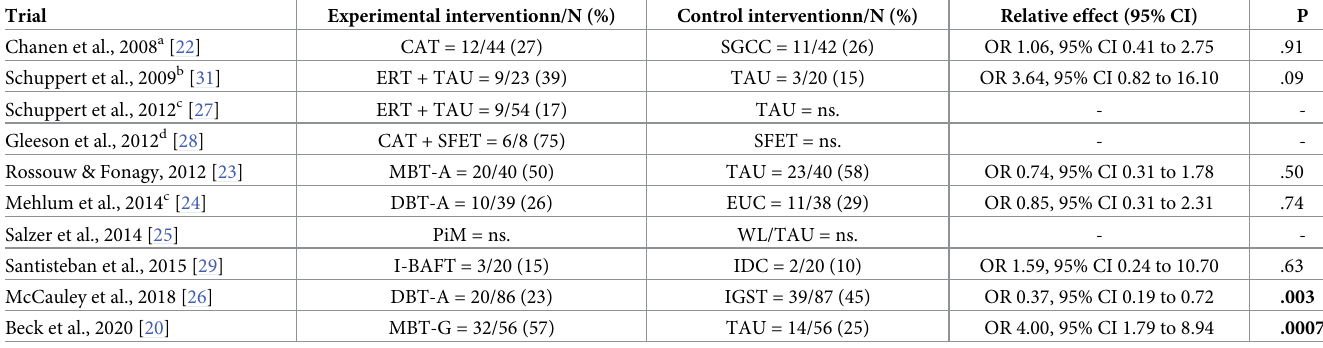
Table 4. Attrition rates in the included